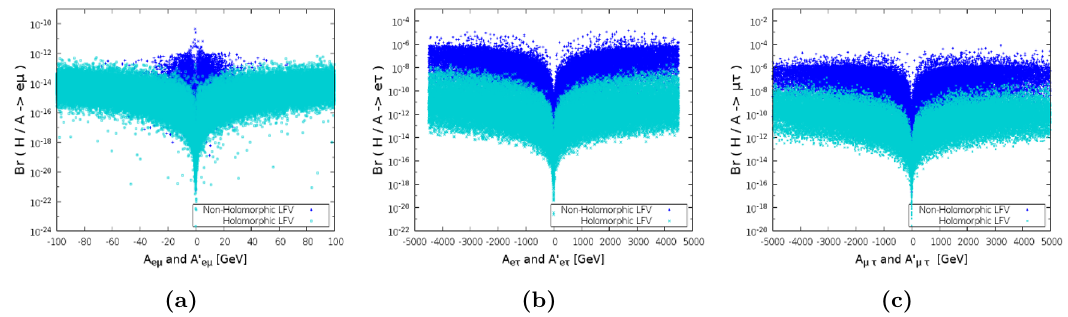
Figure 11. E(cid:11)ect of imposing the LHC constraints on Y ij on the analysis of (cid:12)gure 8: scatter plots of Br ( H=A e(cid:22) ) with A e(cid:22) and A 0 ! A e(cid:28) and A 0 are shown in (cid:12)gure 11(b). Figure 11(c) is for Br ( H=A e(cid:28)